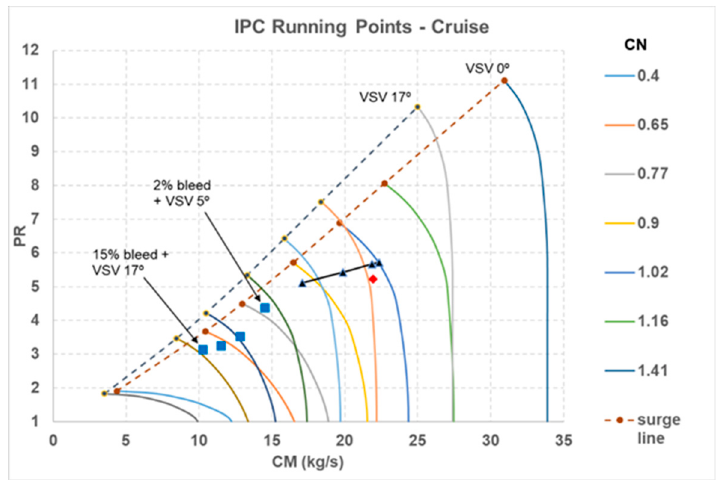
Figure 10. IPC running line at cruise.